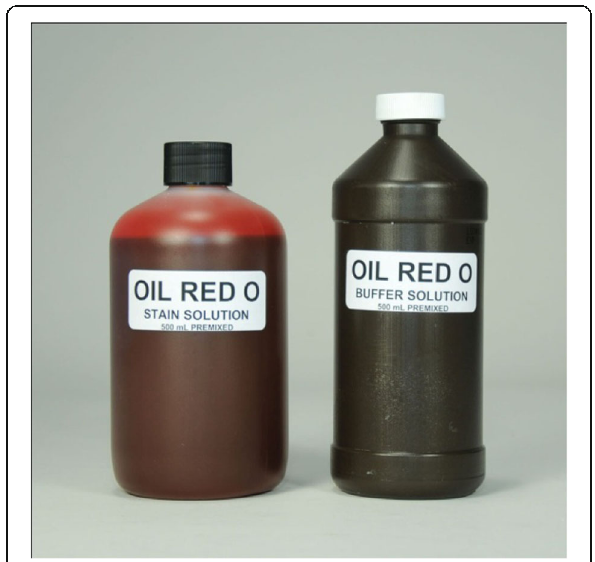
Fig. 3 The stain and buffer solutions for Oil Red O